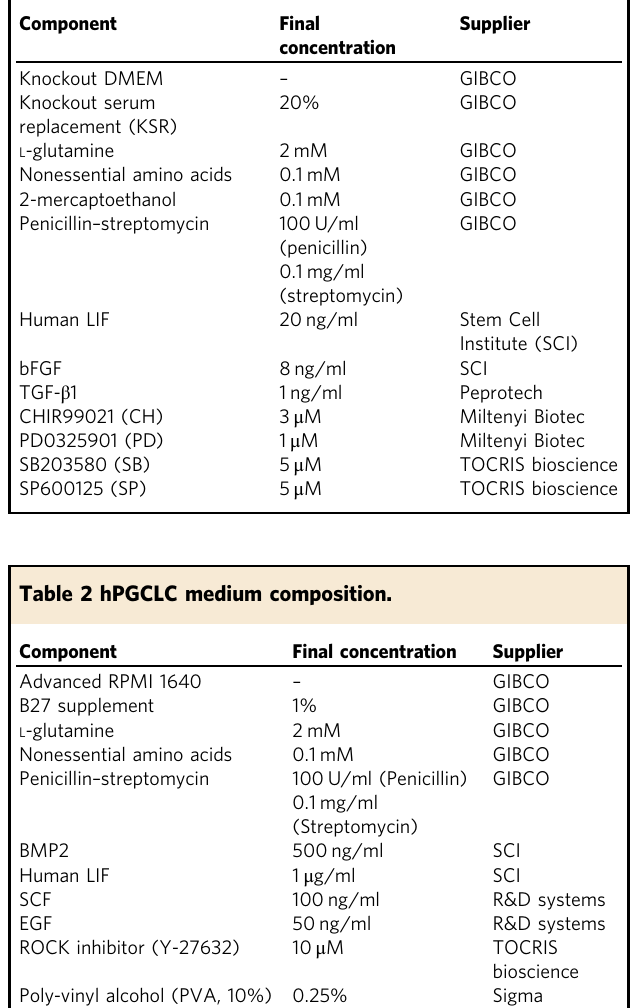
Table 1 4i medium